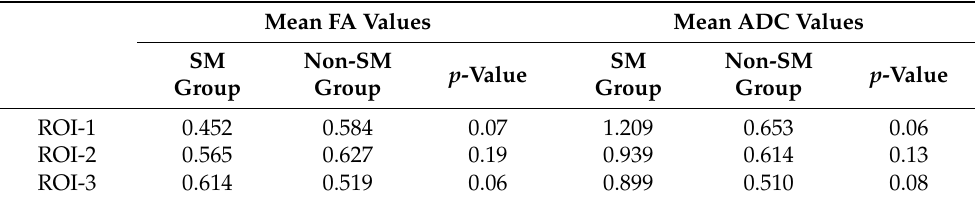
Table 4. Comparison of FA and ADC values in ROI-1, ROI-2, ROI-3 between the SM and non-SM